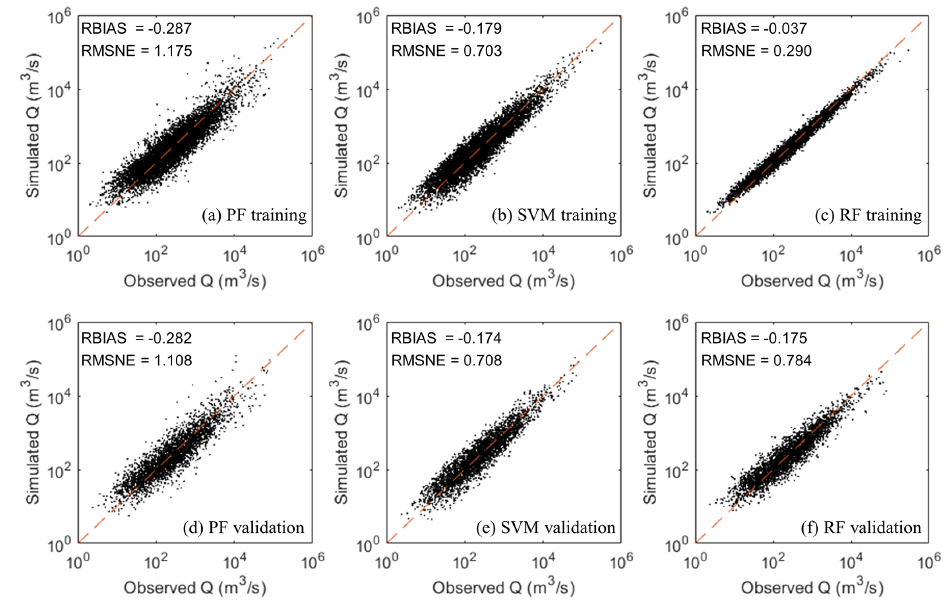
Figure 6. Comparison of three regression models (PF, SVM and RF) during training and validation periods.